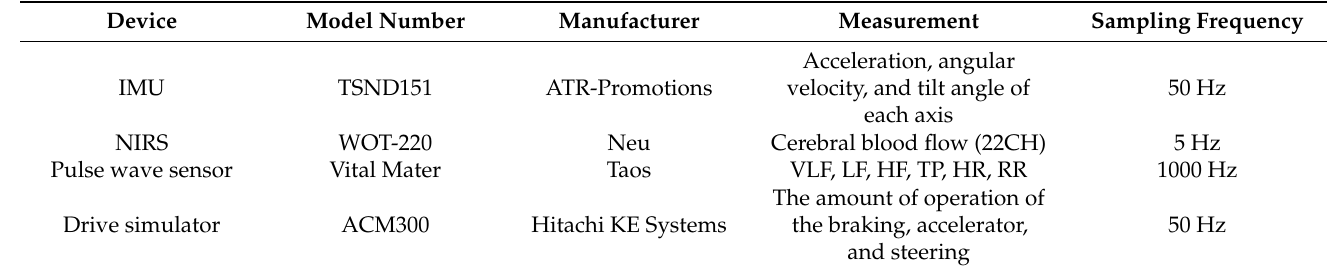
Figure 4. Measurement environment. Table 2. The specifications of the measuring